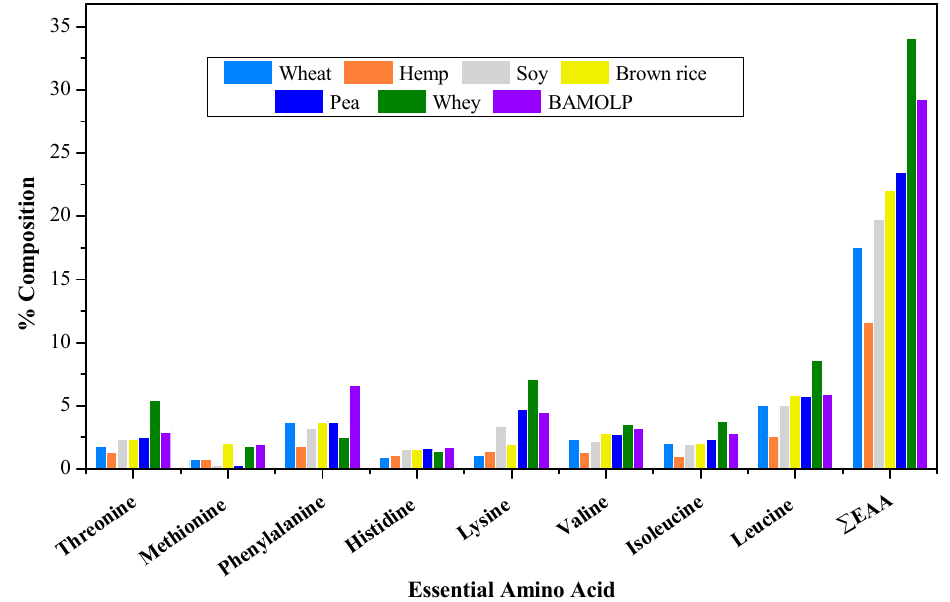
Figure 3. Comparison of amino acids in Bambara groundnut protein complex and other protein sources. BAMOLP: BGN and Moringa protein complex; Σ EAA: total essential amino acid. Methionine content of BGNPI and MOLPI was 1.77 and 2.50 g/100 g, respectively. Table 4. Functional properties of BGNPI, MOLPI, and BAMOLP 1 . These values are appreciable since methionine is usually deficient in legumes and green leaves [21,37,40,41]. The methionine content of 1.77 g/100 g obtained in this study for BGNPI was higher than 1.27 g/100 g reported by [21] for BGN protein. Importantly, methio- nine 1.86 g/100 g in BAMOLP is higher than (0.3) g/100 g in soya bean, and